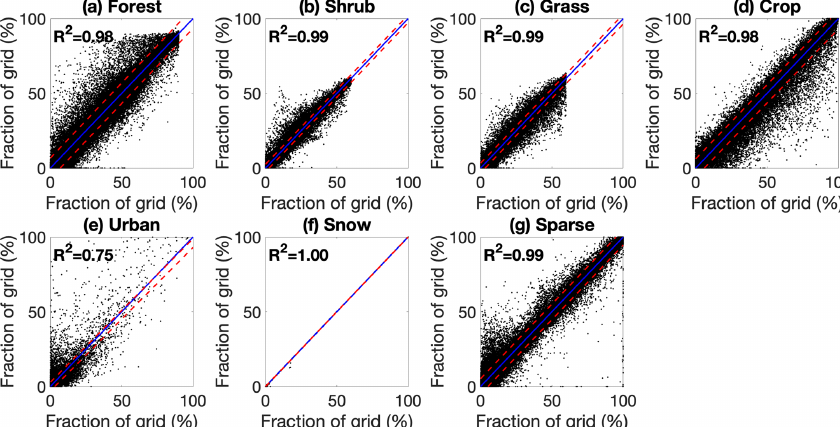
Figure 6. Comparison between the observed and downscaled final land types with optimal parameters over the 265852 0.25 ◦ grid cells in 2015. The blue solid lines show the 1:1 line, and the red dashed lines show the 95% confidence